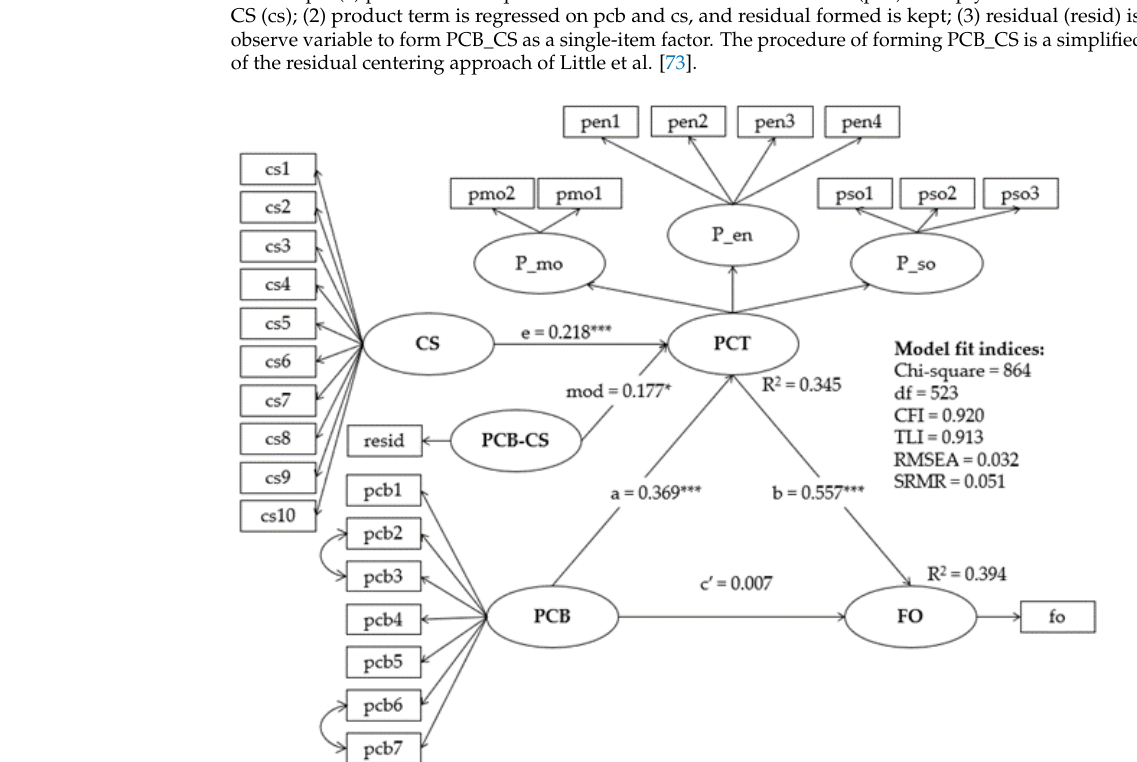
Figure 5. Standardized path coefficients of moderated mediation structural equation model (out- come variable = AA). ** refers p < 0.05 and *** refers p < 0.001. Note. PCB = Perceived crime benefit, PCT = Proactive criminal thinking, P_mo = Mollification, P_en = Entitlement, P_so = Super-opti- mism, CSE = Criminal self-efficacy, AA = Arrest avoidance CS = Crime strategy. PCB_CS = Interac- tion between PCB and CS. 4. Discussion